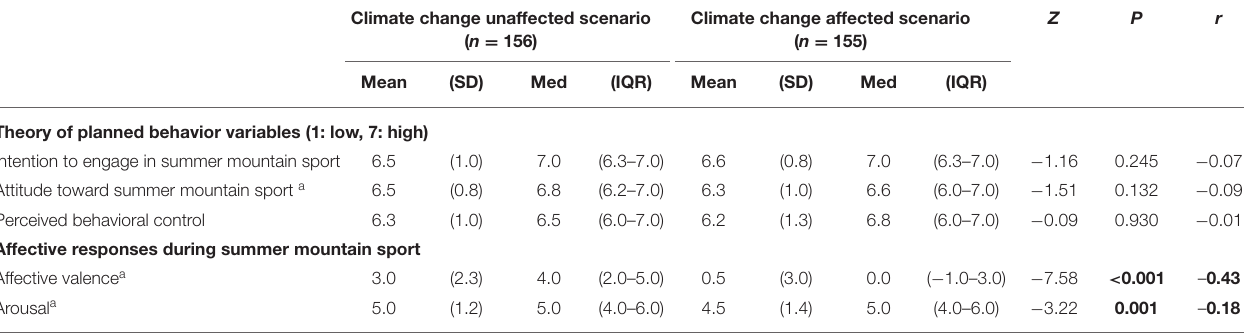
TABLE 2 | Theory of Planned Behavior variables, affective responses, and future summer mountain sport activity engagement by group. Climate change unaffected scenario ( n =